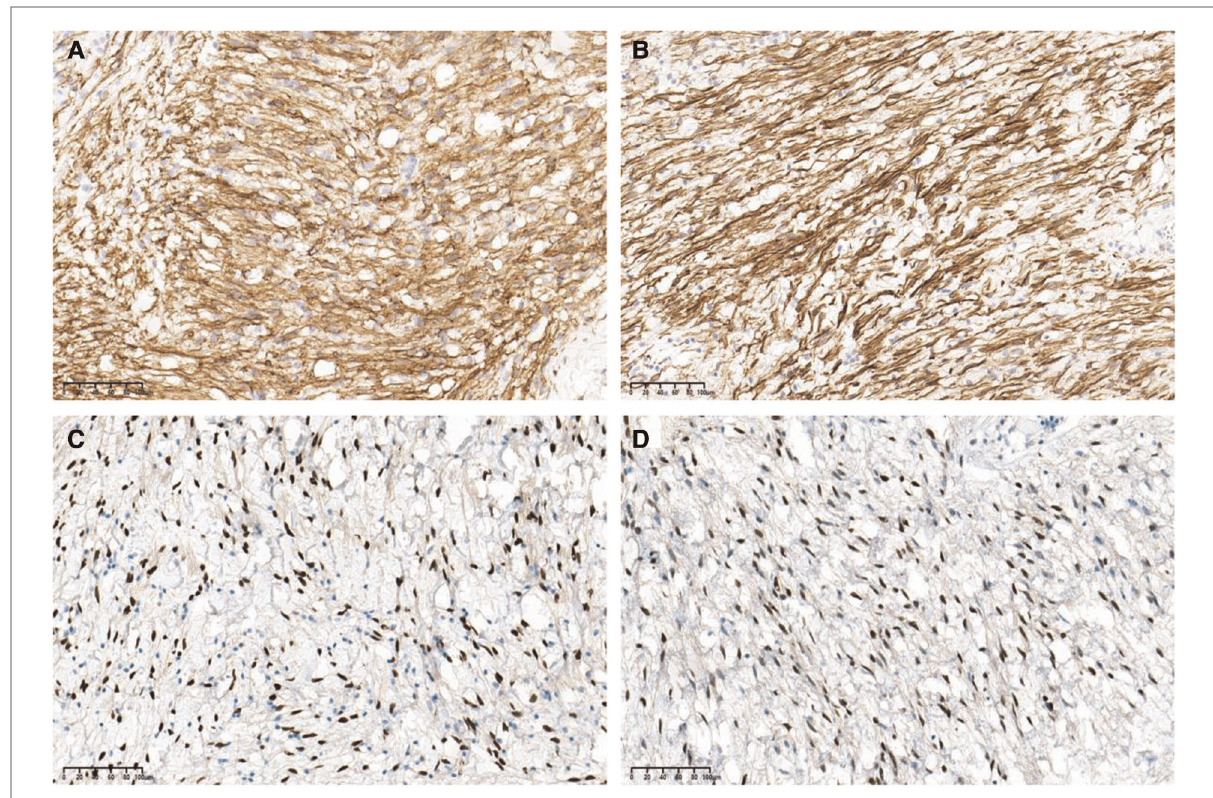
FIGURE 3 The tumor cells are positive for ( A ) CD34, ( B ) desmin, ( C ) estrogen receptor (ER), and ( D ) progesterone receptor (PR) (immunohistochemical stain, ×200 magni fi